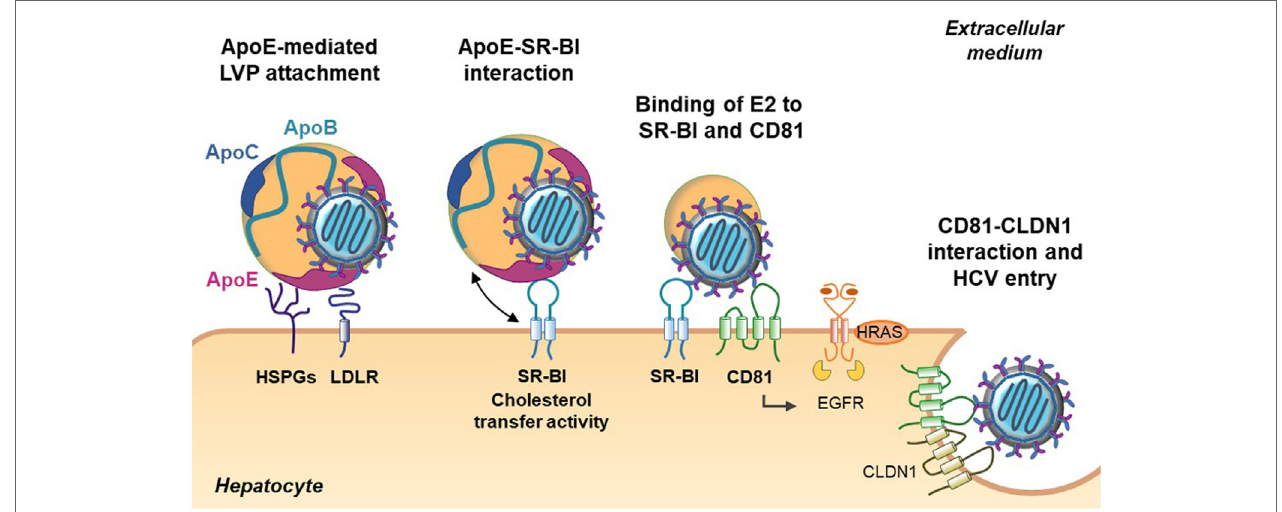
FigURe 2 | Role of apolipoproteins during early steps of hepatitis C virus (HCV) entry. The first step of HCV entry consists of the interaction between lipo-viro- particle (LVP)-associated ApoE, the heparan sulfate proteoglycans (HSPGs), and the low-density lipoprotein receptor (LDLR). Subsequently, the LVP interacts with the scavenger receptor class B type I (SR-BI) through ApoE and ApoB (not illustrated). The cholesterol transfer activity of SR-BI allows E2 exposure and binding of E2 to SR-BI and the tetraspanin CD81. Binding on CD81 activates the epithelial growth factor receptor (EGFR) signaling pathway and interaction between CD81 and claudin 1 (CLDN1) that triggers HCV